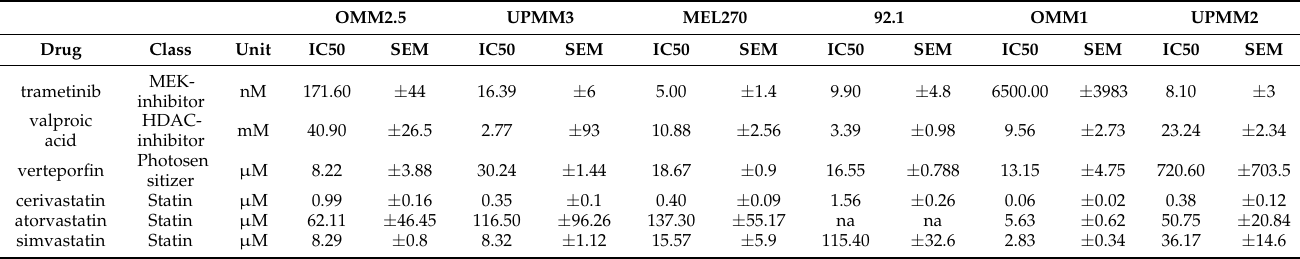
Table 2. IC50 values of the drugs tested in UM cell lines.